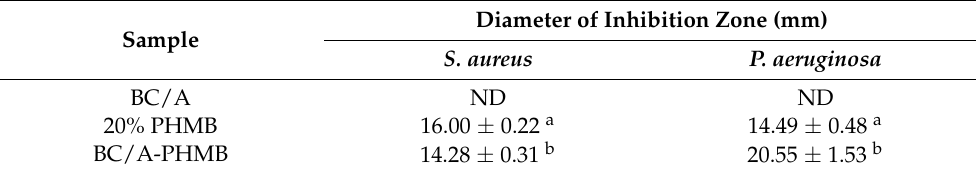
Table 6. Antibacterial activity of BC/A-PHMB against S. aureus and P. aeruginosa